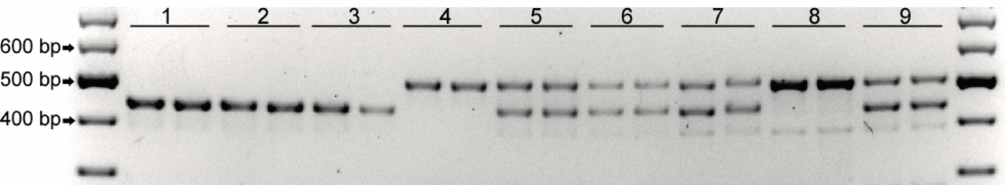
Figure 1. Monitoring the introgression of downy mildew resistance locus from A. roylei into A. cepa genome using PCR with DMR1 marker [22]. Lines 1: A. cepa var. ‘Exhibition MS’; lines 2: A. cepa var. ‘Hiberna’, lines 3: A. cepa var. ‘Valencia’; lines 4: A. roylei ; lines 5: F 1 A. cepa